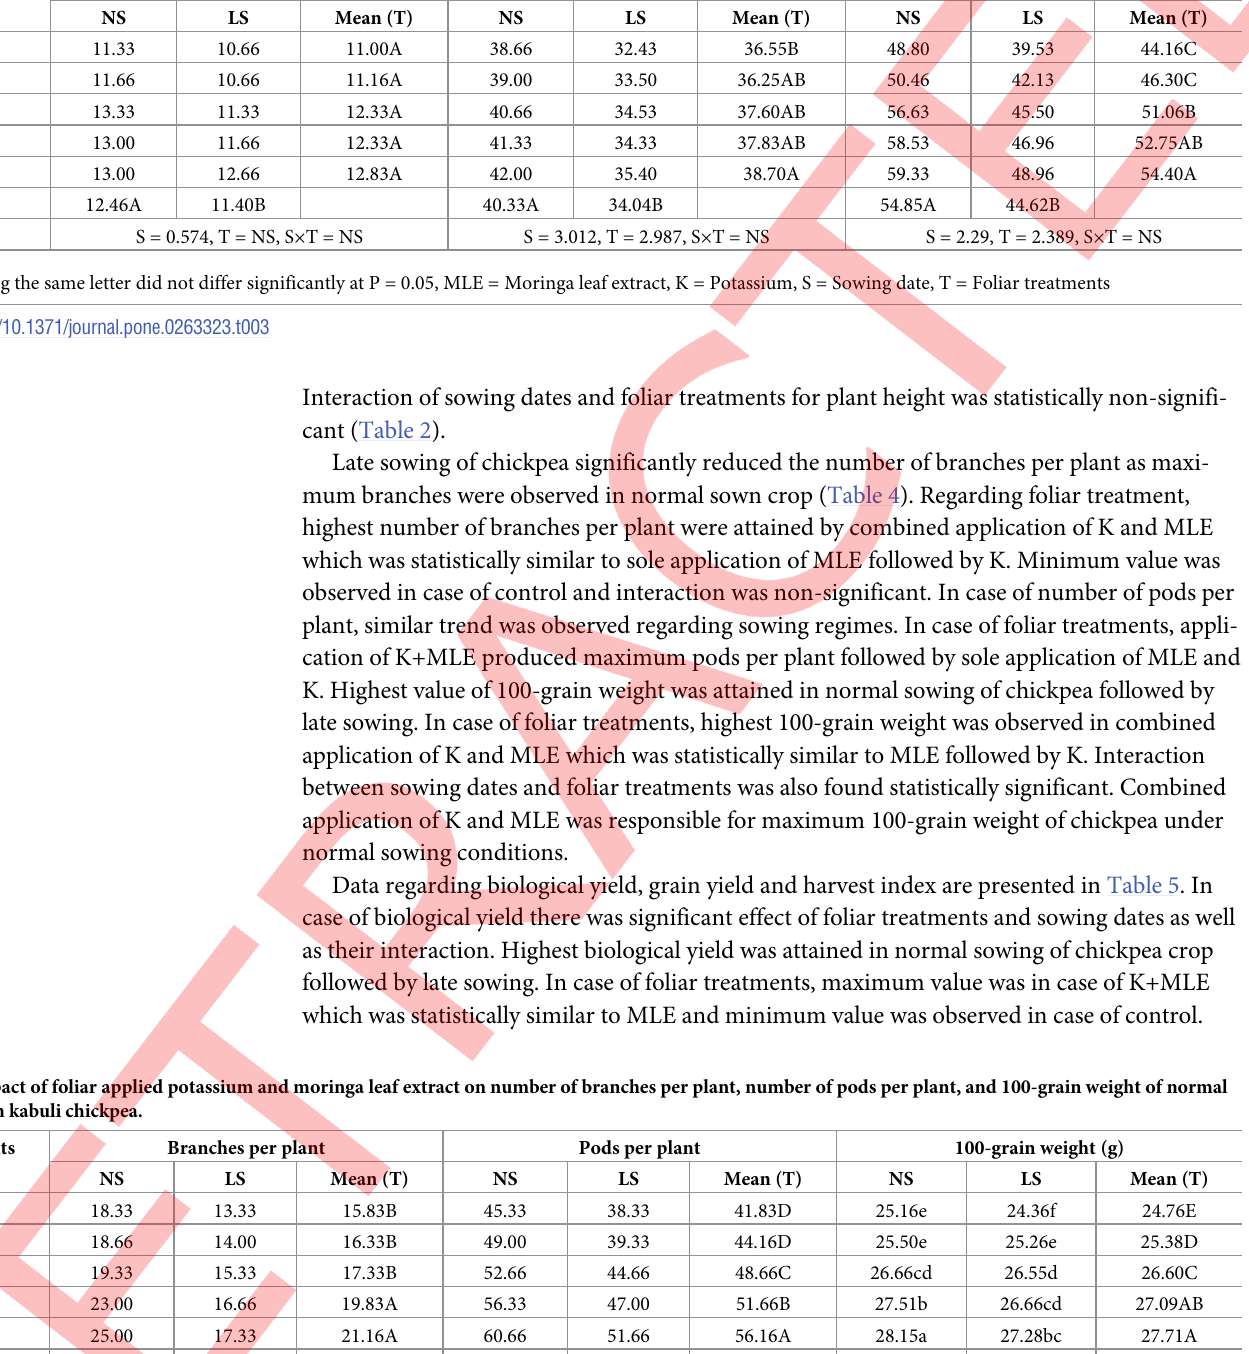
Table 3. Impact of foliar applied potassium and moringa leaf extract on number of nodules per plant, nodules dry weight (mg) and growth and plant height (cm) of normal and late sown kabuli chickpea. Treatments